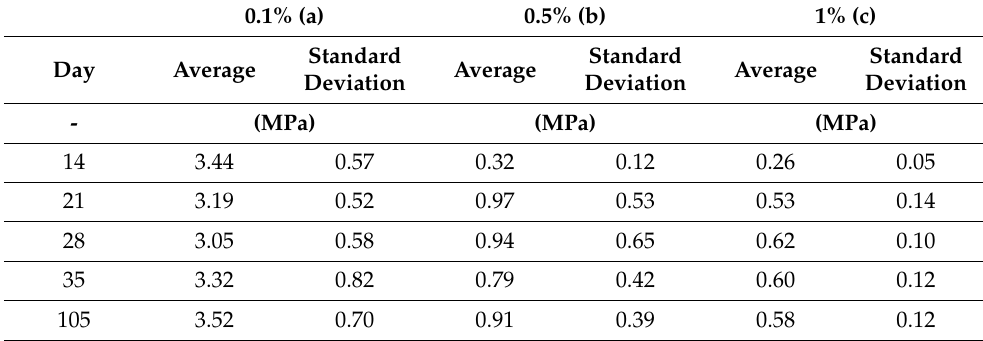
Table 3. The results obtained during the compressive strength